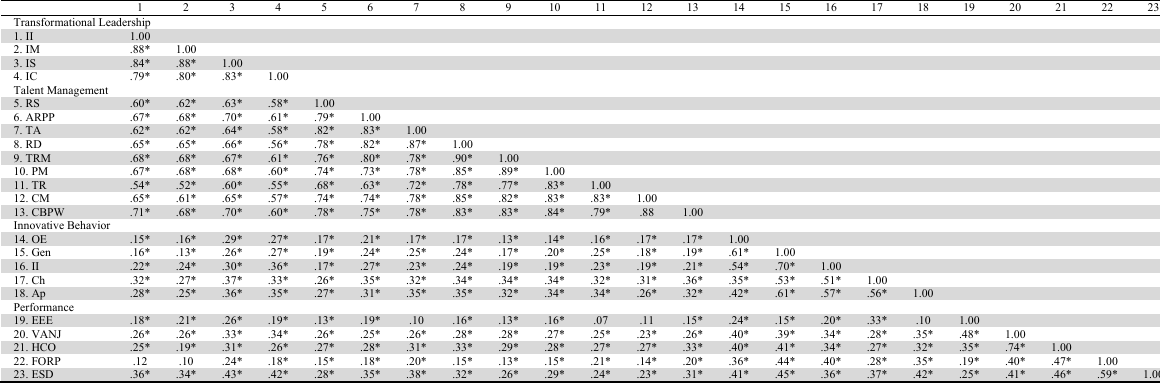
Table 3 Summary of path coefficients and t values Hypothesis Path Coefficients